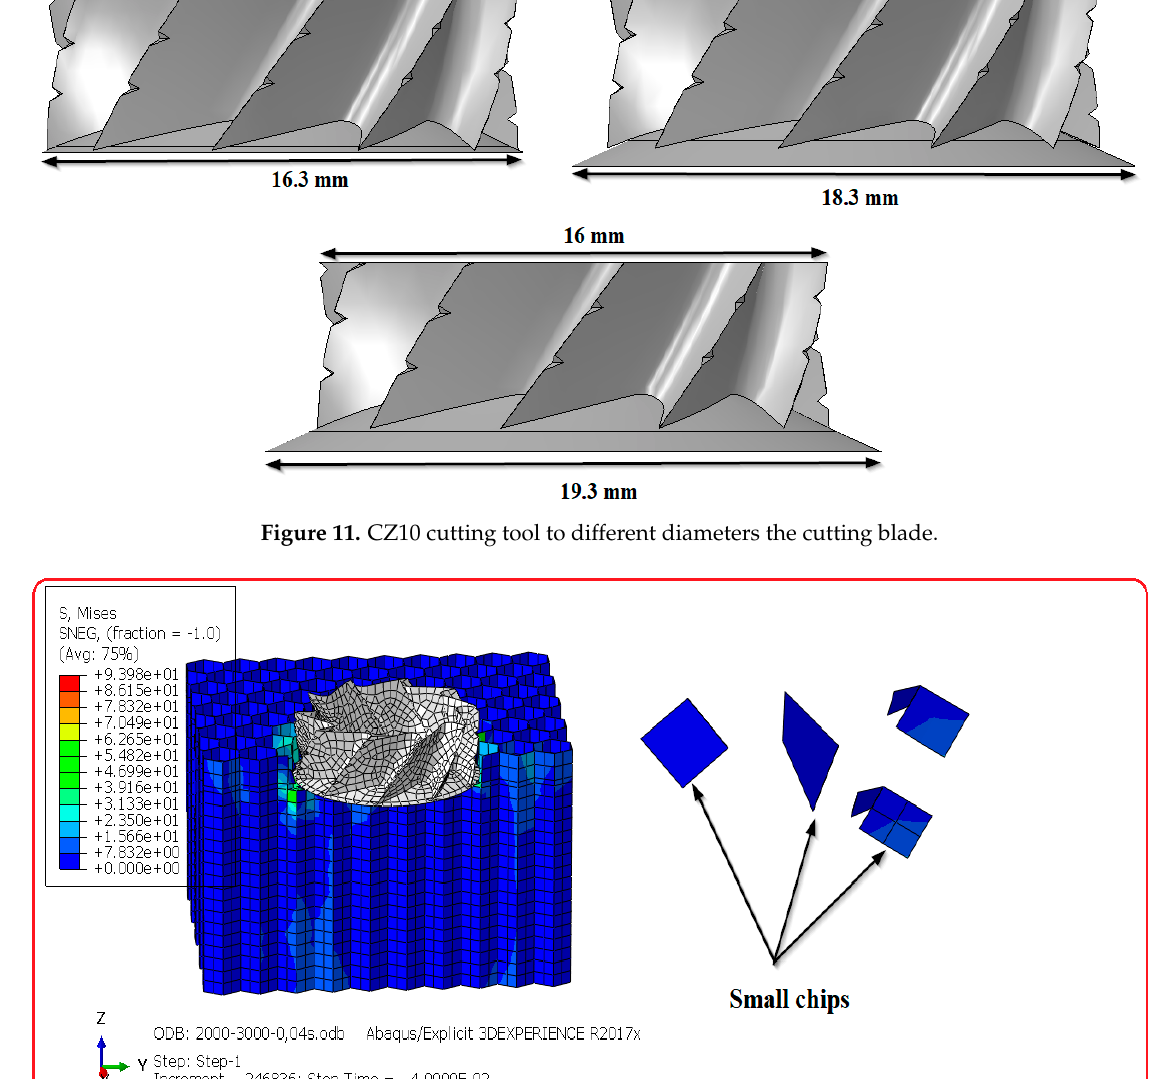
Figure 13. Resulting chip size by the diameter-cutting blade of 18.3 mm.